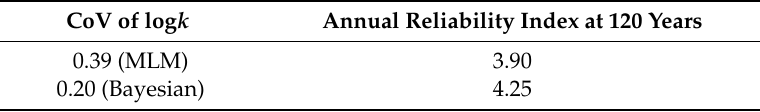
Table 4. Annual reliability index as function of CoV of log